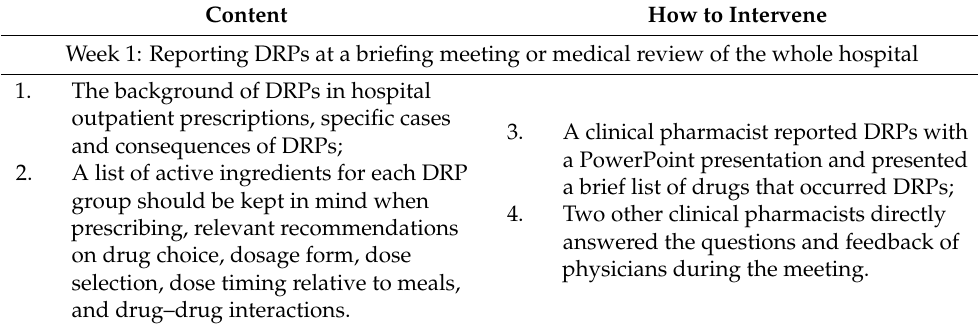
Table 1. Contents of interventions and